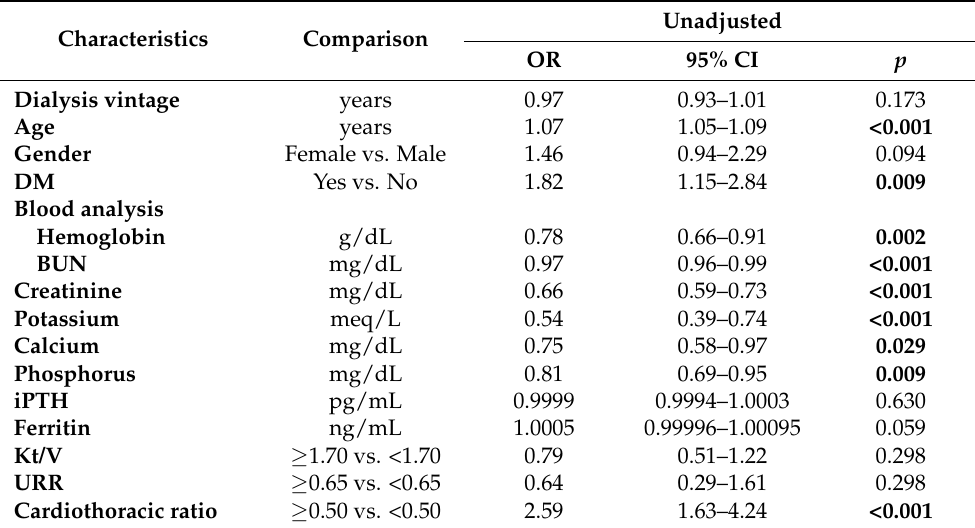
Table 2. Univariate logistic regression analysis for time-averaged serum albumin (TSA) category.